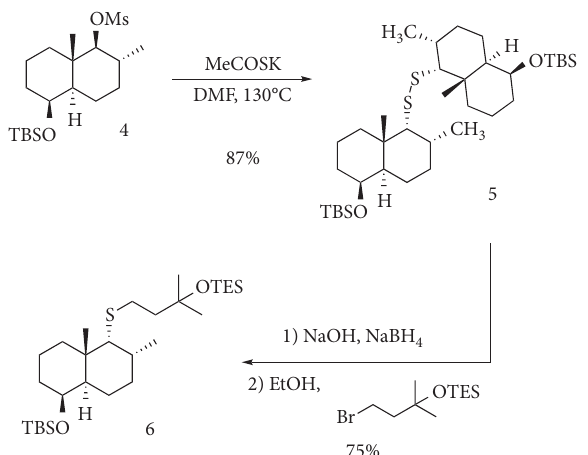
Scheme 2: Obtention of key intermediate 6 from mesylate 4.